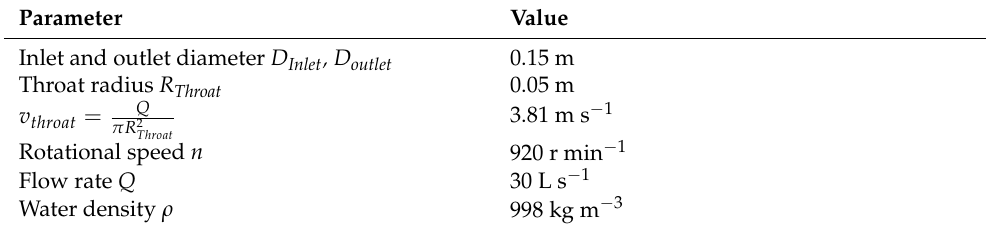
Figure 1. Schematic of the swirl generator and position of velocity measured using laser Doppler velocimetry (LDV). Table 1. Parameters of the swirl generator.